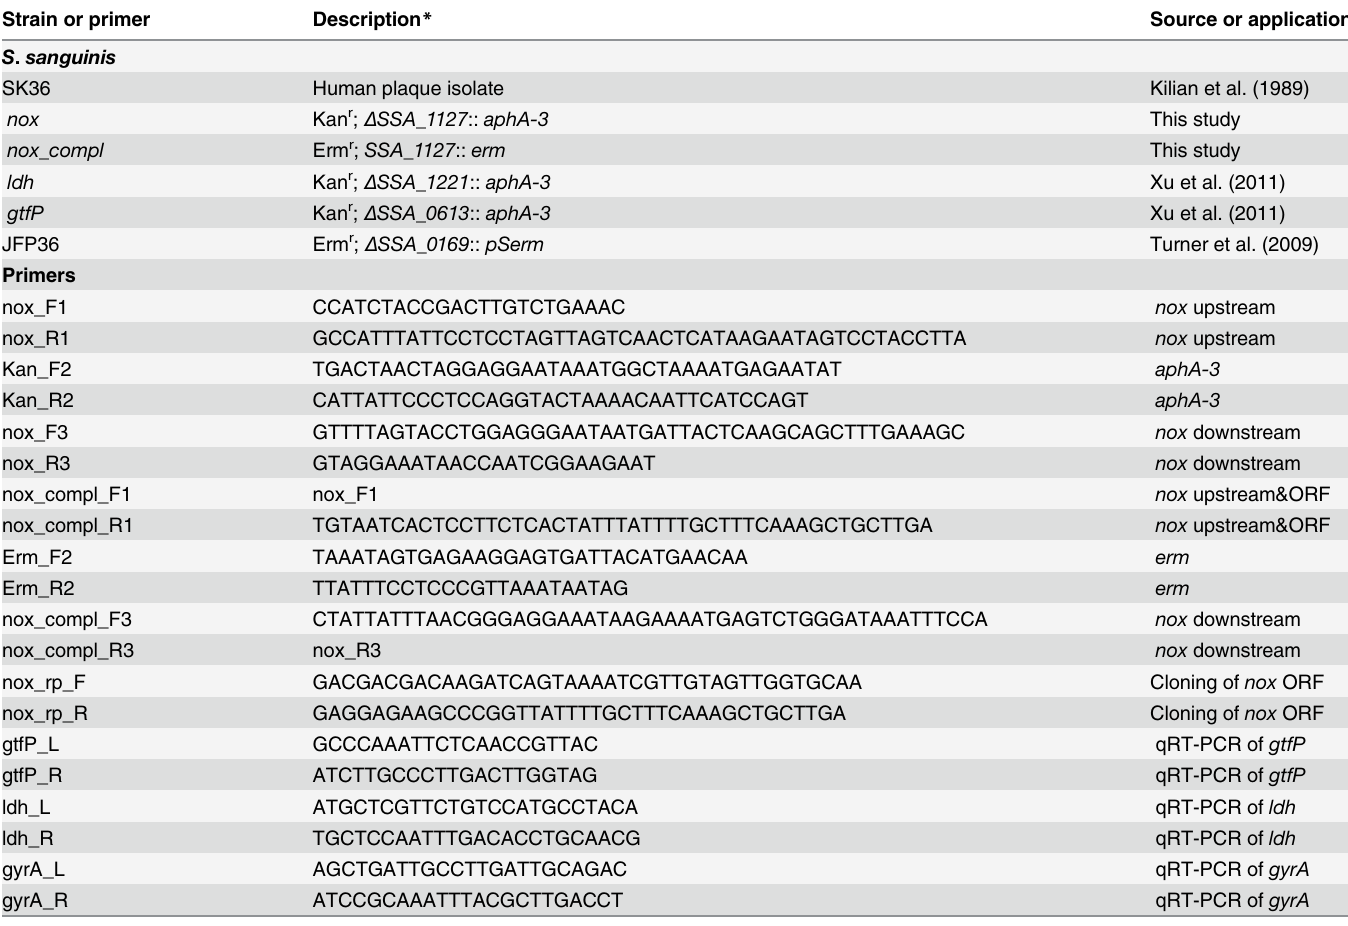
Table 1. Strains and primers in this study. Strain or primer Description